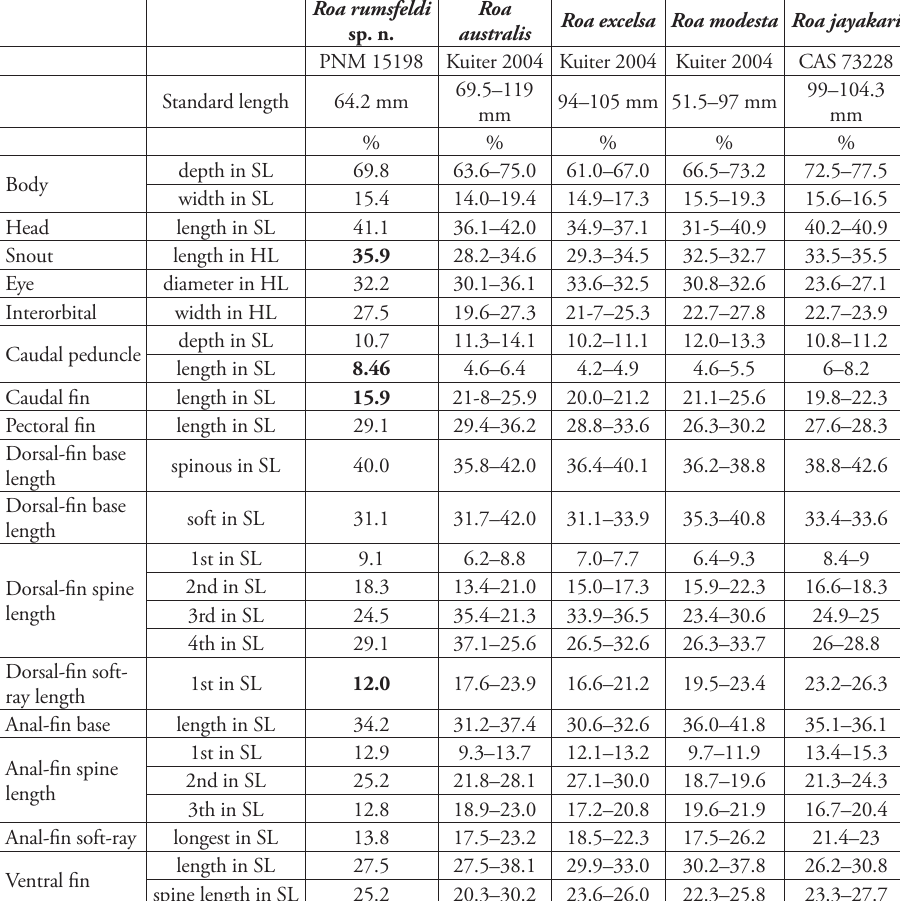
Table 1. Proportional measurements of Roa species. Values that do not overlap between Roa rumsfeldi sp.n. and the other species are in